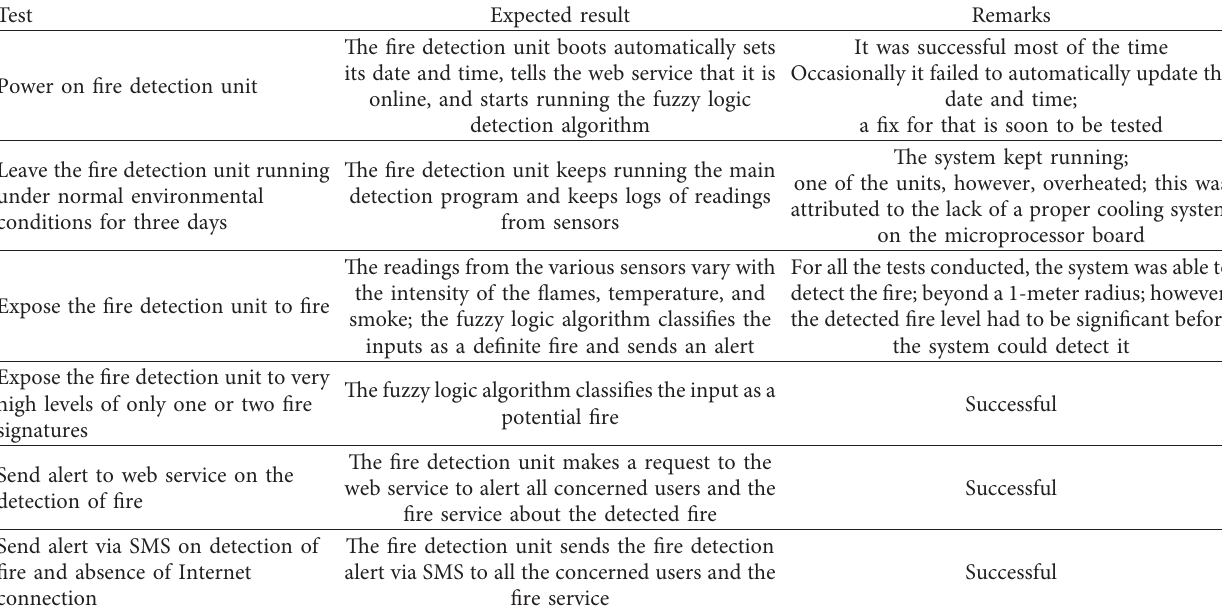
(e) Table 5: Field test